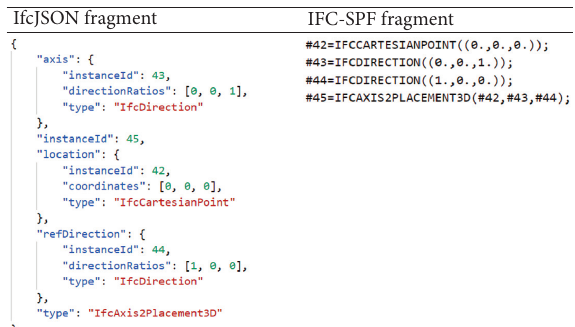
Figure 1: Expression comparison between IfcJSON and IFC-SPF format.